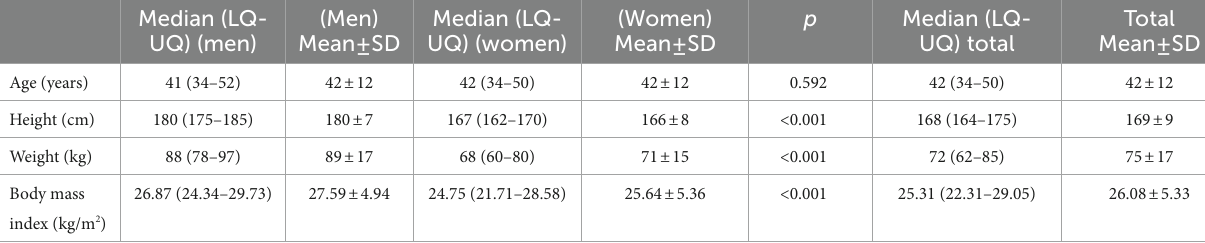
TABLE 1 Characteristics of studied population ( N = 397 men, N = 1,370